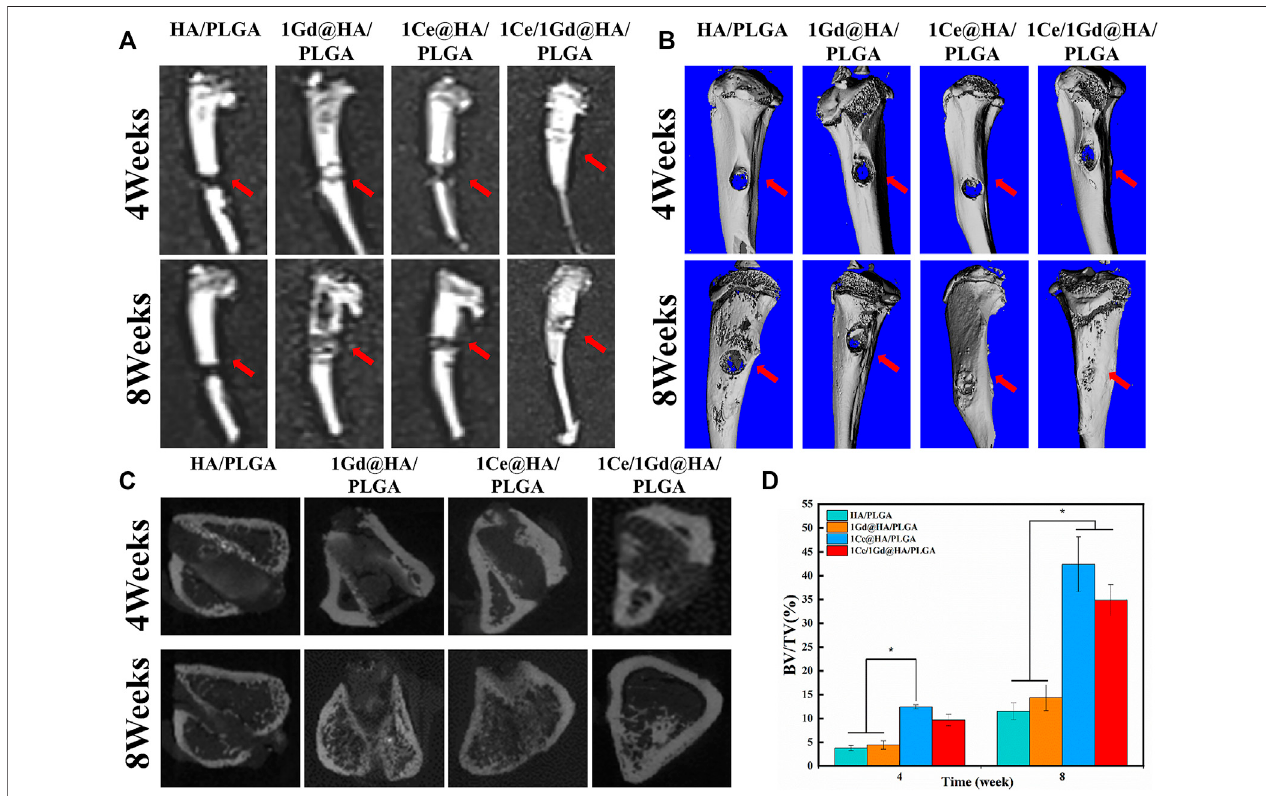
FIGURE10|(A) T1MRIimagesofratsafter4and8 weeksofoperation. (B) Three-dimensionaland (C) sagittalplanesoftheratnewbonewerereconstructedat4 and 8 weeks after operation, and (D) the regenerated bone bv/TV was quantitatively analyzed by HA/PLGA, 1Ce@HA/PLGA, 1Gd@HA/PLGA, and 1Ce/1Gd@HA/ PLGA scaffolds. The red arrow indicates the location of the bone defect. * p <